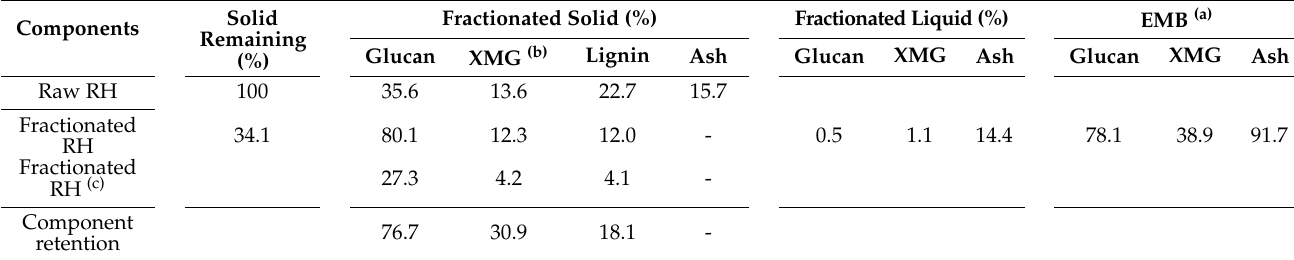
Table 3. Chemical composition of raw rice husk (RH) and NaOH-fractionated RH based on oven-dry